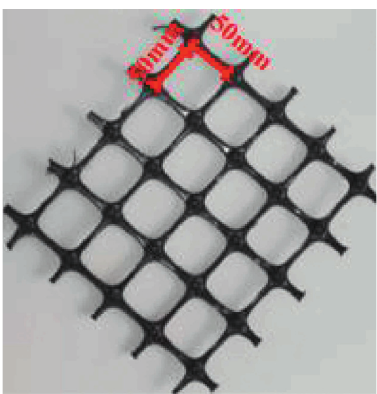
Figure 8: Biaxial